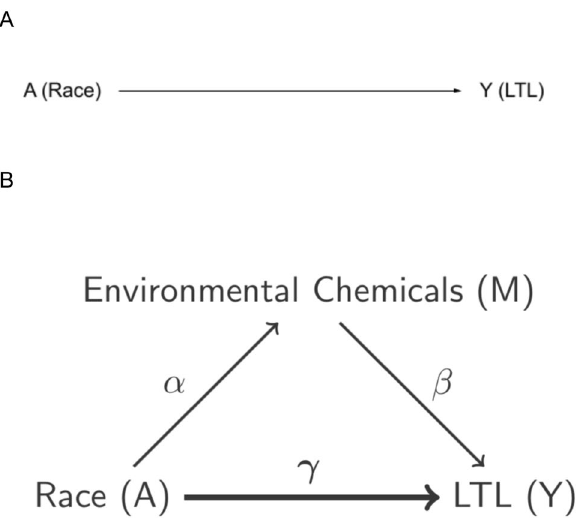
Figure 1. Conceptual models being considered in this work. Panel ( A ) shows the total effect model (conditional on adjustment covariates). In panel ( B ) we show the mediation model. The bolded line and corresponding coefficient show the direct effect. α aj and β mj ( j = 1,…, 15 contaminants) show the relationships between race and the chemical and the chemical and LTL for each chemical